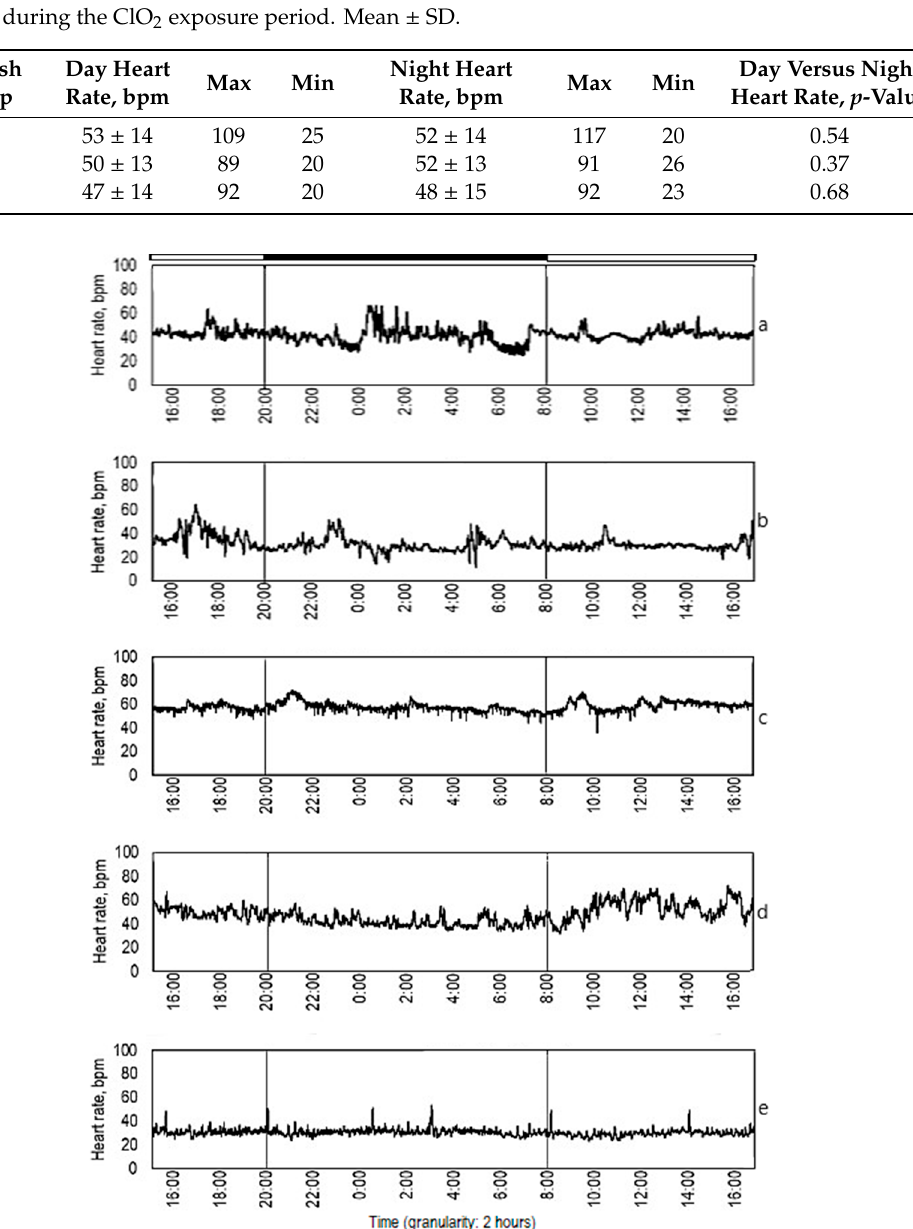
Figure 3. Examples of heart rate of five crayfish P. leniusculus during the day and night period, 5th to 6th of June 2017 with ClO 2 concentrations of 0.25 mg L − 1 and 0.19 mg L − 1 , respectively. The fluctuating line indicates heart rate in beats per minute (bpm), while the two vertical lines distinguish night- and day-time. Table 2. Average heart rate expressed as beats per minute of all monitored crayfish from the three groups during the ClO 2 exposure period. Mean ± SD.